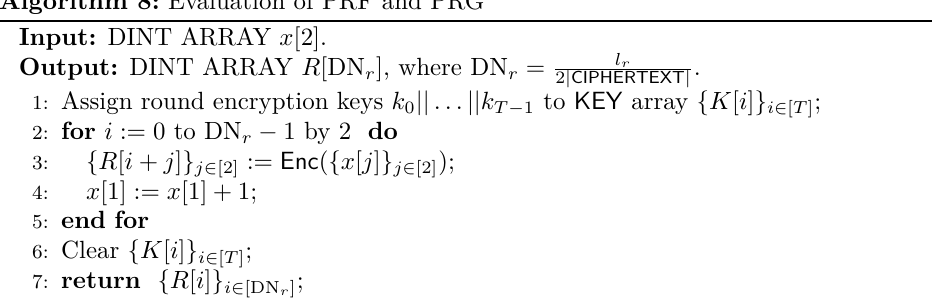
Algorithm 8: Evaluation of PRF and